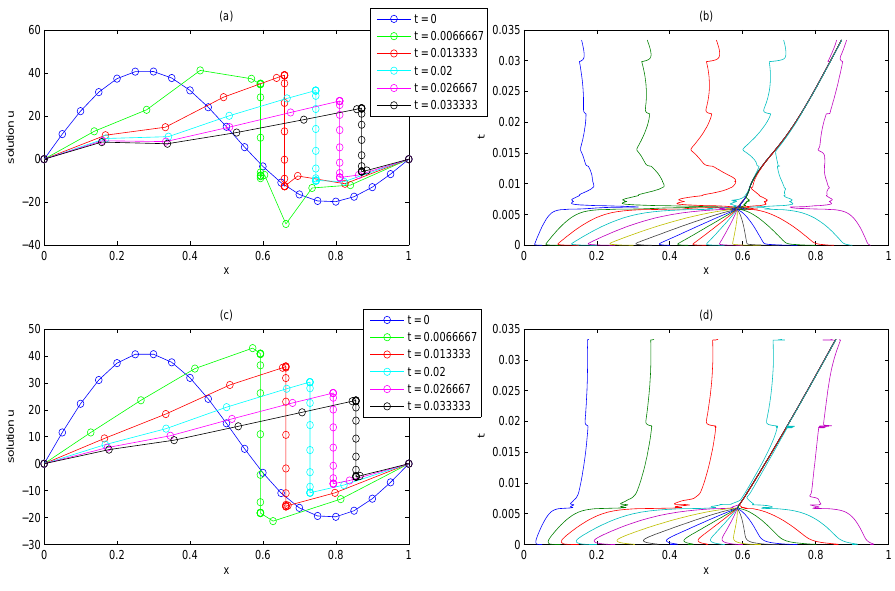
Figure 5. Numerical solutions and trajectories of Burgers equation with n = 30 applying Huang’s method ( a , b ) and proposed method ( c , d ).